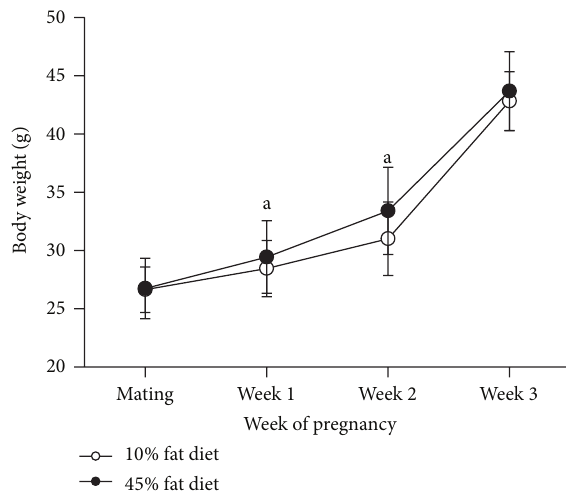
Figure 4: Body weight development (in gram) of dams during pregnancy, that is, from mating to the end of week three of pregnancy (mean ± SD). The dams were given either a 10% fat (open circles) or a 45% fat (filled circles) diet in this period. 𝑛 = 41 – 123 . a Significantly higher with a 45% fat diet versus a 10% fat diet in the same